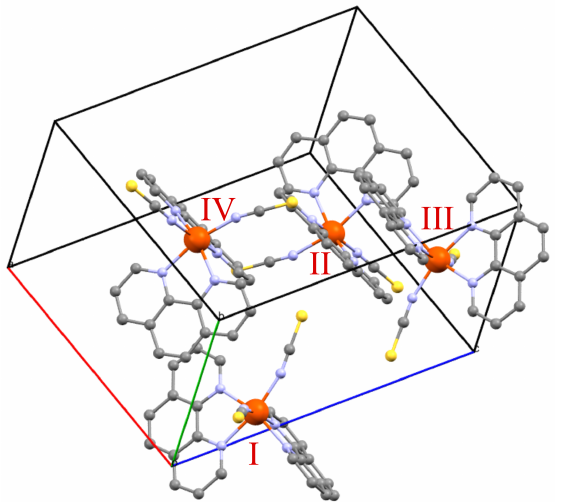
Figure 1. Calculated unit cell of the low spin (LS) phase of [Fe(phen) 2 (NCS) 2 ] with four symmetry equivalent molecules labelled with Roman numbers (colour scheme: Fe (red), S (yellow), N (blue), and C (grey); hydrogens are omitted for clarity). Molecules I and IV are located in a sheet parallel to the a–b plane, a second parallel sheet contains molecules II and